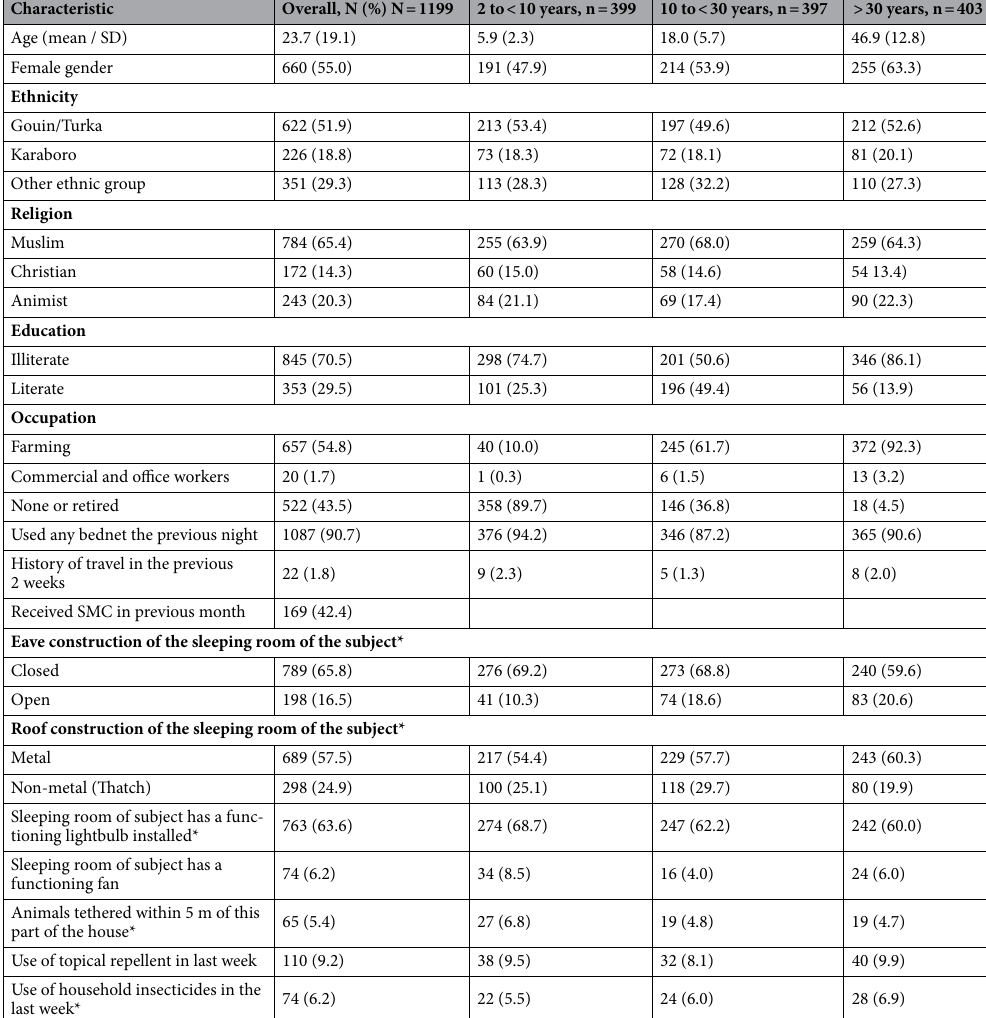
Table 1. Characteristics of participants of the cross-sectional survey. *Missing